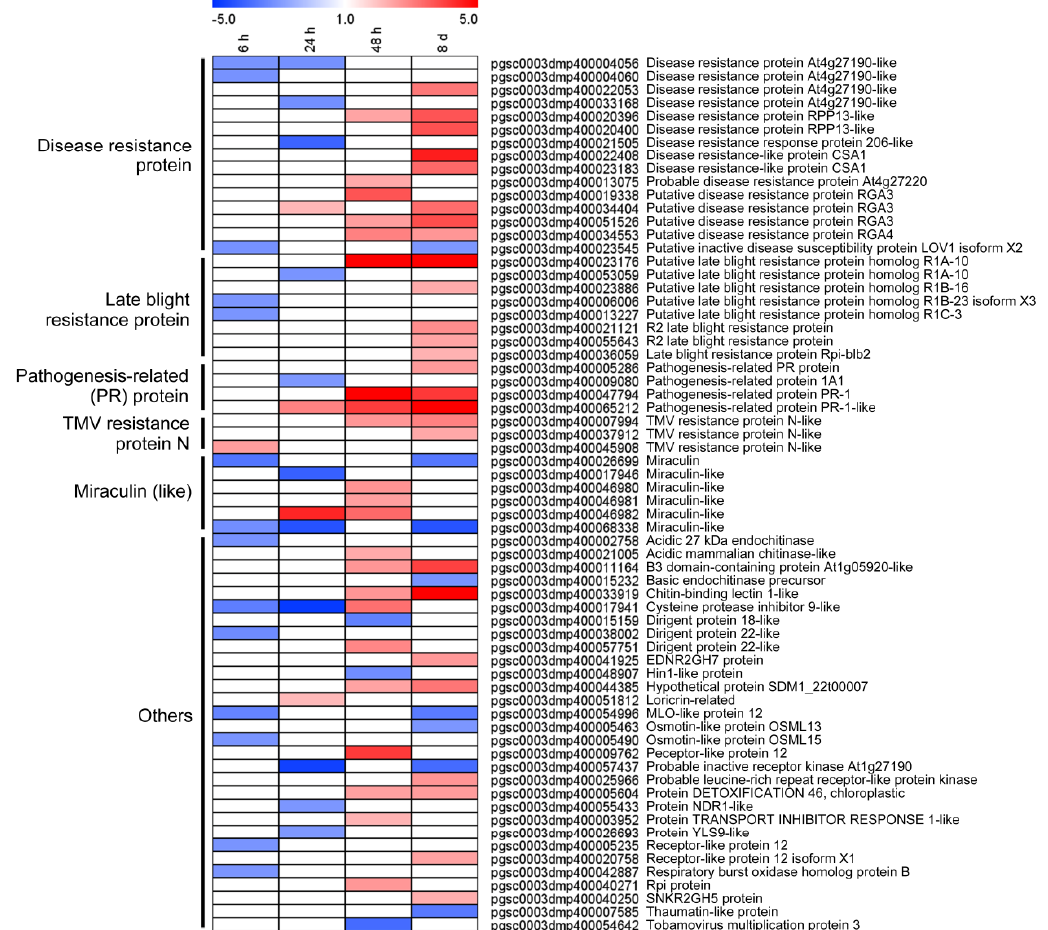
Figure 6. Heat map showed transcriptional profiles of biotic-related DEGs, which included disease resistance proteins, late blight resistance proteins, PR (pathogenesis-related) proteins and so on. Bins in red are transcribed at higher levels; bins in blue are transcribed at lower levels. Results indicate that stronger activation of biotic-related bins occurs in the later stage.